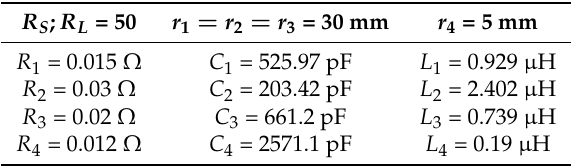
Table 1. Calculated values of the loops elements.